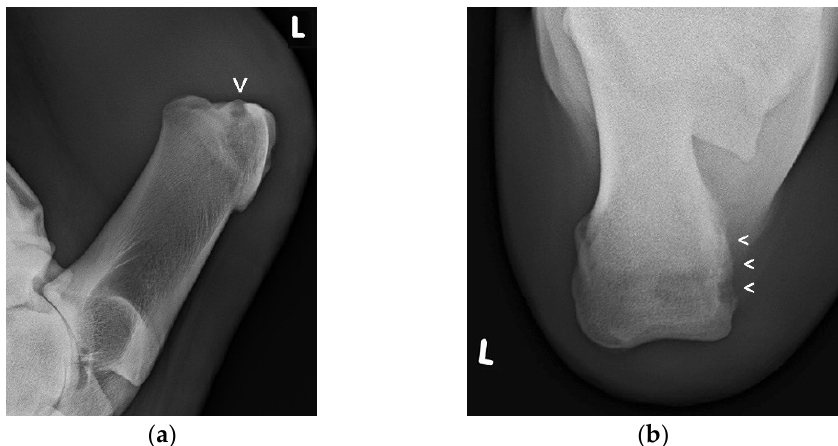
Figure 3. Lateromedial ( a ) and proximodistal radiographic views ( b ) of the left CT region of this cow showing an extended radiolucent zone (small arrow/s) at the proximomedial aspect of the CT, indicating bone osteolysis (Figure 3a,b courtesy of the Clinical Unit of Diagnostic Imaging, Vetmeduni Vienna, Austria). Table 1. Radiographic findings in 19 cattle with septic bursitis of the SCB.